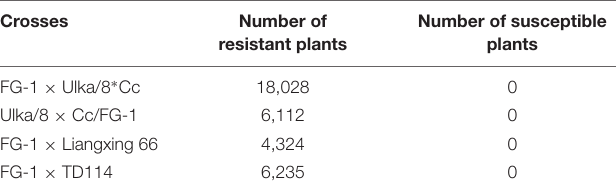
TABLE 3 | Phenotype reactions of the F 2 populations from the cross between FG-1 and the wheat lines Ulka/8 ∗ Cc with Pm2a , Liangxing 66 with PmLX66 and TD114 with Pm2a + Pm6 when tested with Bgt isolate